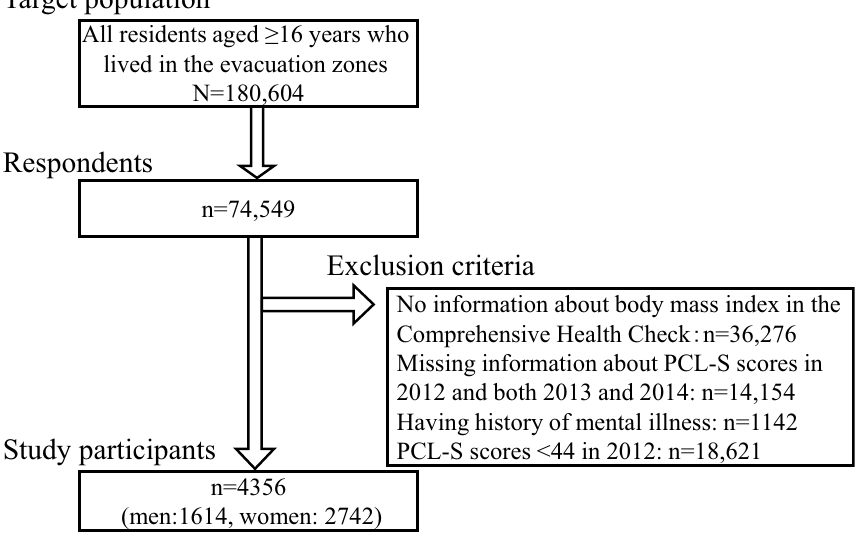
Figure 1. Flow diagram of the study